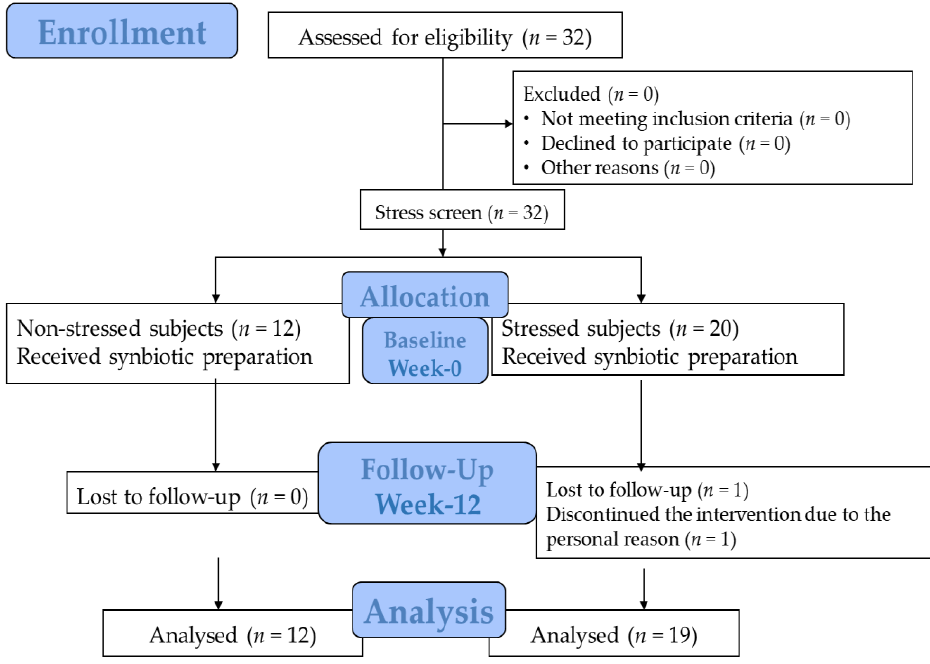
Figure 1. The allocation and follow-up chart.